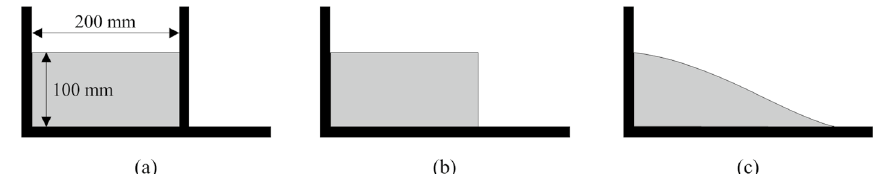
Fig. 12 Experimental procedure: a the granular column supported by two walls, b the soil column just after the right wall is removed, c collapsing granular